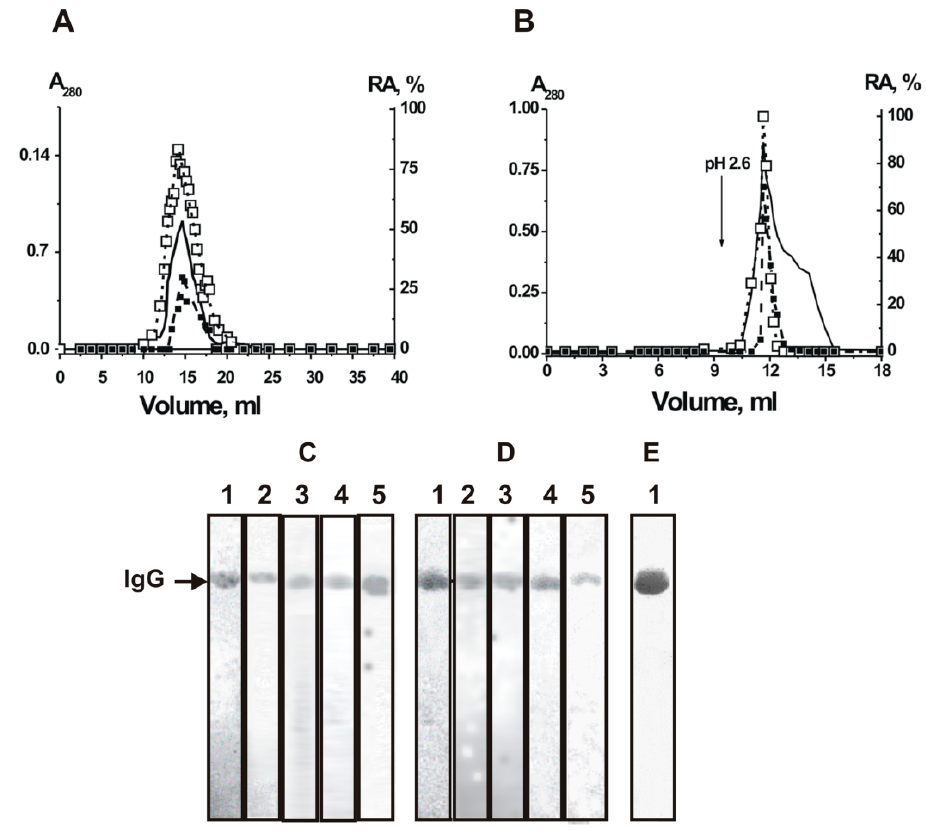
Figure 7. FPLC gel filtration of IgG mix (mixture of 10 preparations) on a Superdex 200 column under acidic conditions (pH 2.6) after IgG mix incubation in the same buffer ( A ) and affinity chromatography of IgG mix on Sepharose bearing mouse IgGs against human IgGs ( B ): (—), absorption at 280 nm; relative activity (RA) of IgG mix in peroxidase ( □ ) and oxidoreductase oxidation ( ■ ) of DAB. Relative activity (RA) of the fractions with the highest activity was taken for 100%. In situ SDS-PAGE analysis of five different IgGs peroxidase ( C , lanes 1–5; 10 µ g of Abs) and oxidoreductase ( D , lanes 1–5; 20 µ g of Abs) activities from five different donors using a nonreducing 4–15% gradient gel ( C , D ) The oxidizing activity of IgGs was revealed by the appearance of a colored oxidation product after incubation longitudinal gel slices in the reaction mixture containing DAB and H 2 O 2 ( C ) or without hydrogen peroxide ( D ). Longitudinal slices of the gels were stained with Coomassie R250 ( E , lane 1) to reveal the positions of IgGs